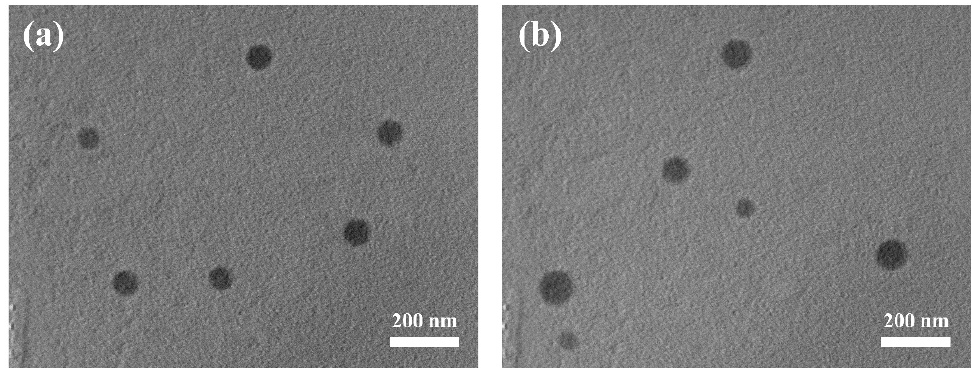
Figure 1. The morphology analysis of nanoparticles using TEM. ( a ) LA-OEI/miR-34a; ( b ) OEI/miR-34a. The scale bar is 200 nm.